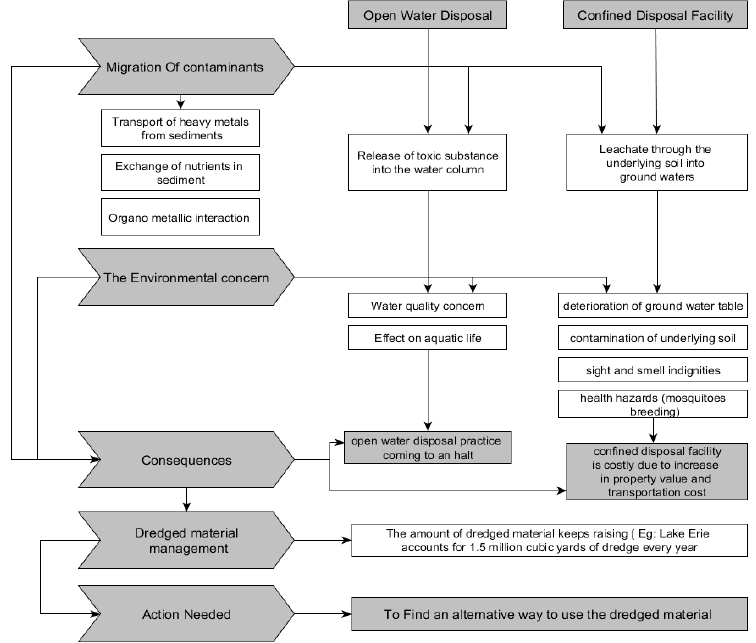
Figure 1. Challenges of Dredged Material Management (Ref: [1–3,6]).